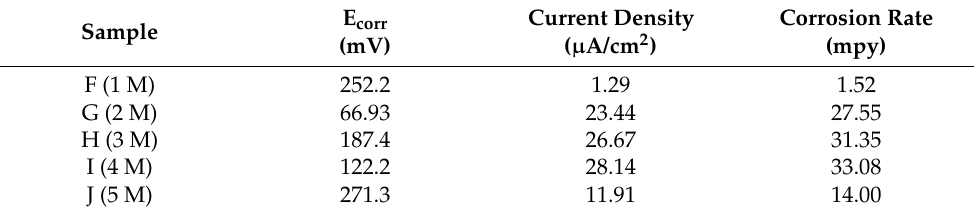
Table 2. E corr , current density, and corrosion rate at 9 V and variations in sulfuric acid concentration. Sample